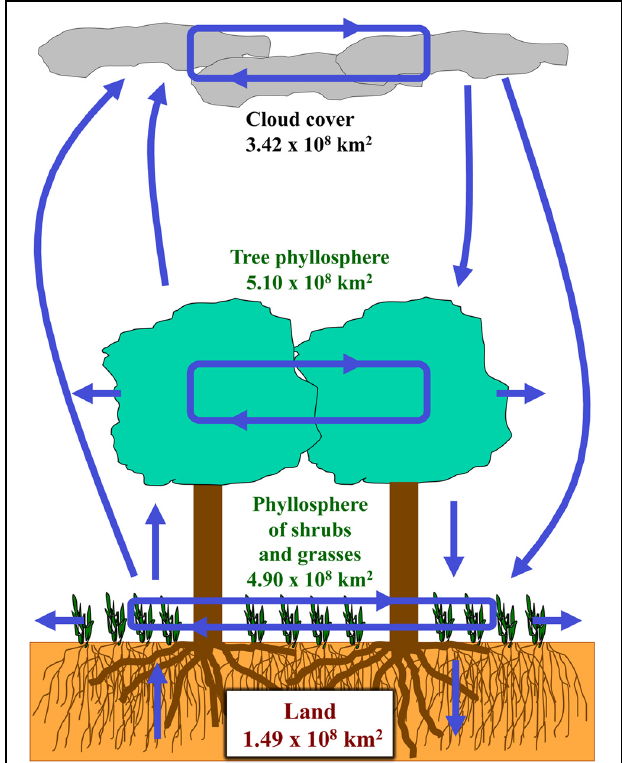
FIGURE 5 | Dynamics of interactions of plant canopies and the atmosphere. Land, plant strata, and cloud strata are represented, with estimates of global earth-wide surfaces, which were derived from recent studies (Friend, 2010; Probst et al., 2012; Vorholt, 2012). Interactions involving fluxes of microbial populations are symbolized by blue arrows (Lindemann et al., 1982; Finkel et al., 2012; Rastogi et al., 2012; DeLeon-Rodriguez et al., 2013; Šantl-Temkiv et al., 2013; Vaïtilingom et al., 2013; Hill et al.,